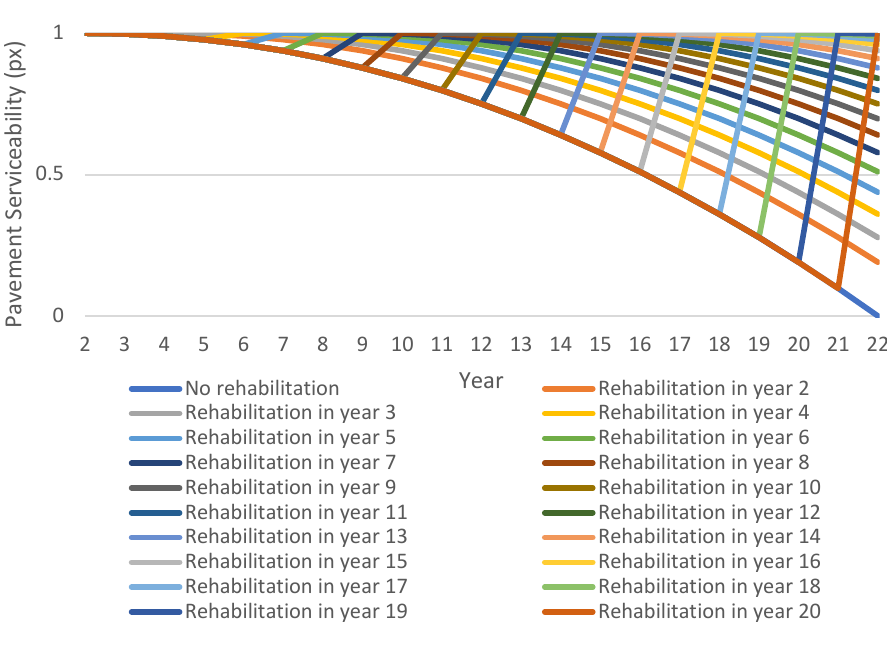
Figure 5. Pavement serviceability — case study.